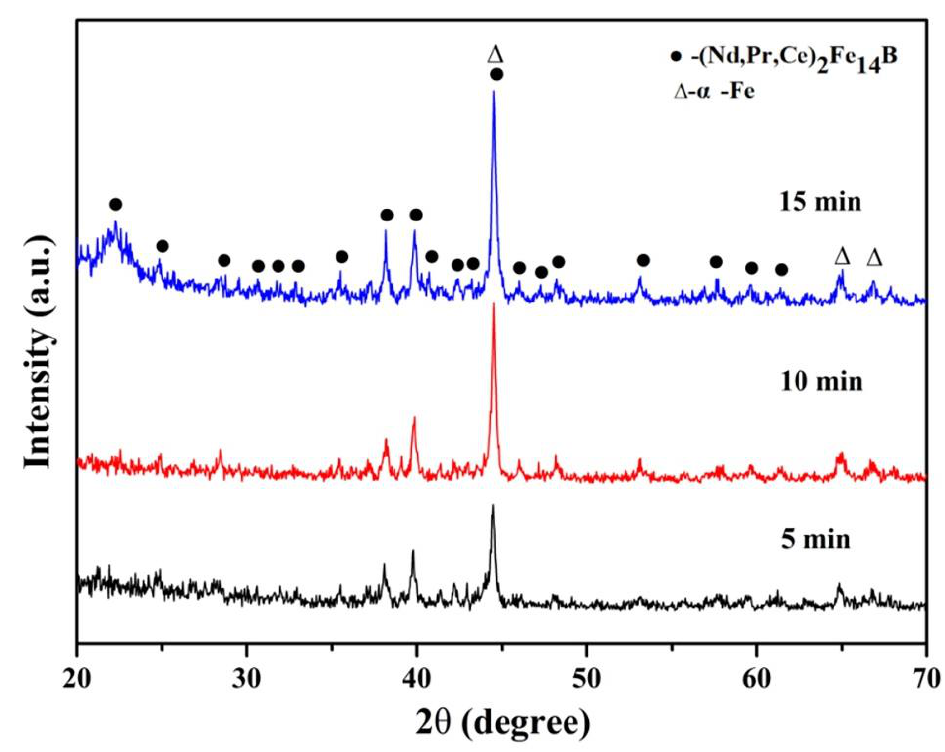
Figure 6. X-ray diffraction patterns of the microwave annealed (Nd 0.525 Pr 0.175 Ce 0.3 ) 9 Fe 64.5 Co 3 Cu 0.5 Ti 1 B 22 ribbons for different time. Table 3. The average crystallites size of the main phases of the microwave annealed (Nd 0 . 525 Pr 0 . 175 Ce 0 . 3 ) 9 Fe 64 . 5 Co 3 Cu 0 . 5 Ti 1 B 22 ribbons for a different time.